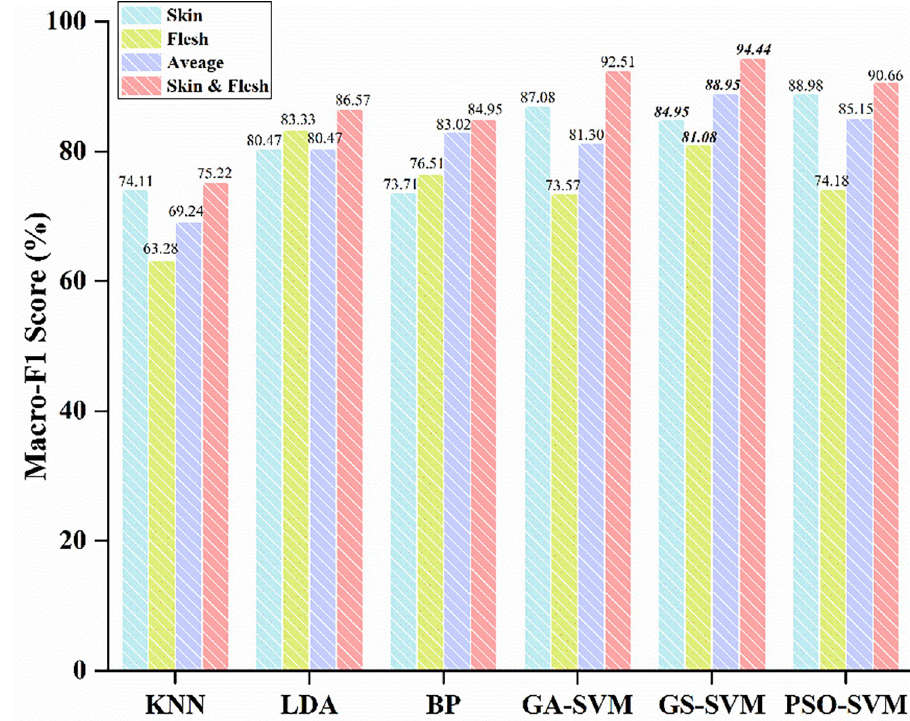
Fig 5. The Macro-F1 score of the